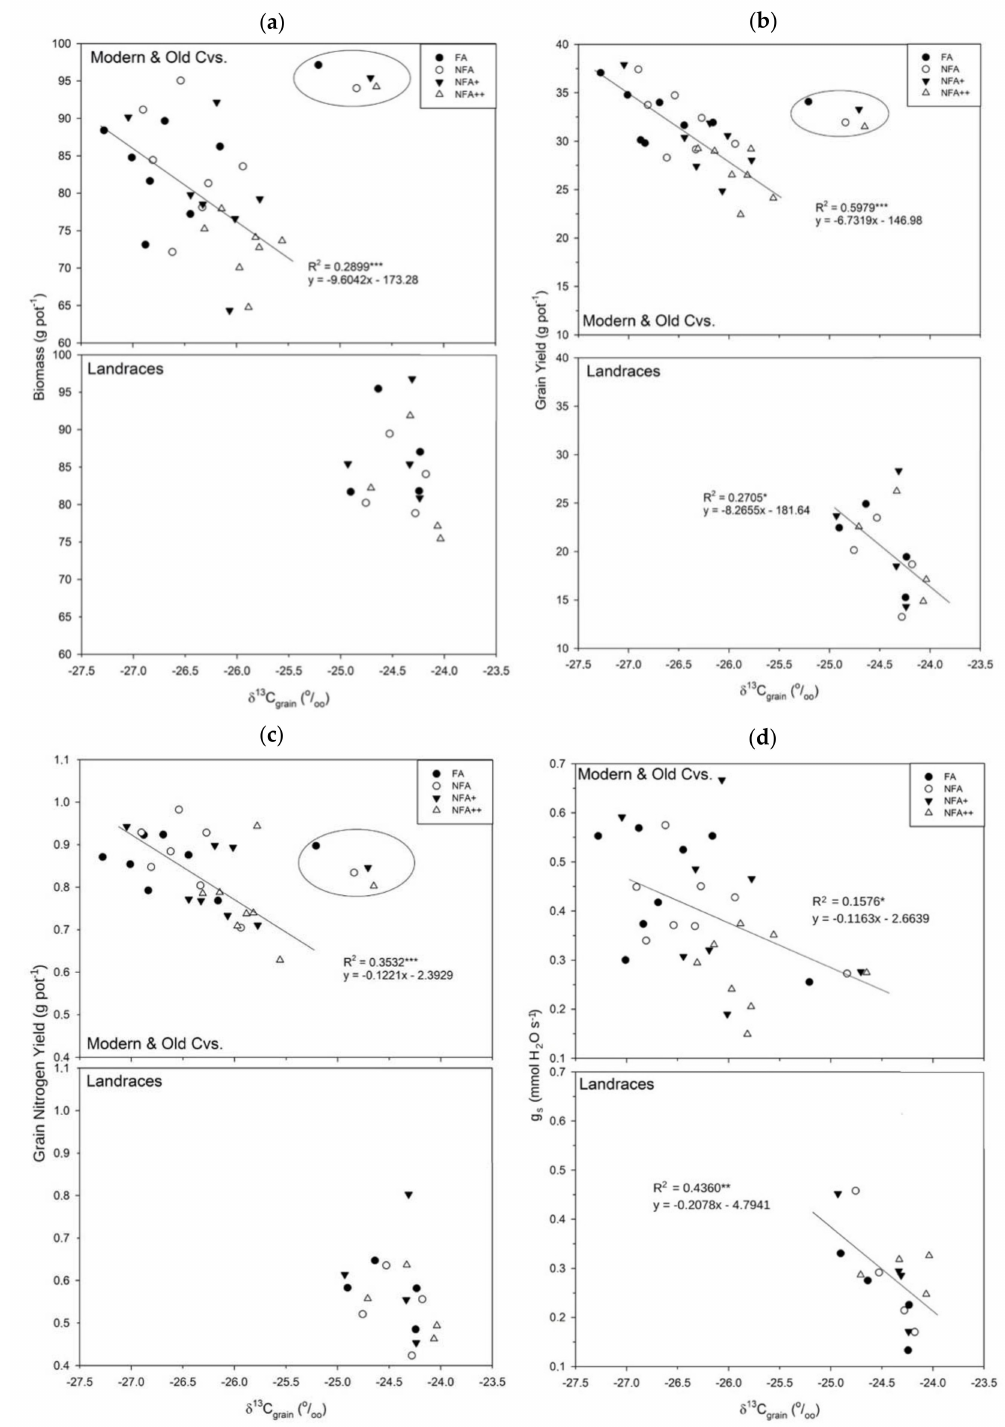
Figure 5. Regression of δ 13 C (‰) with: ( a ) GY (Grain Yield, g pot − 1 ), ( b ) GNY (Grain N Yield,